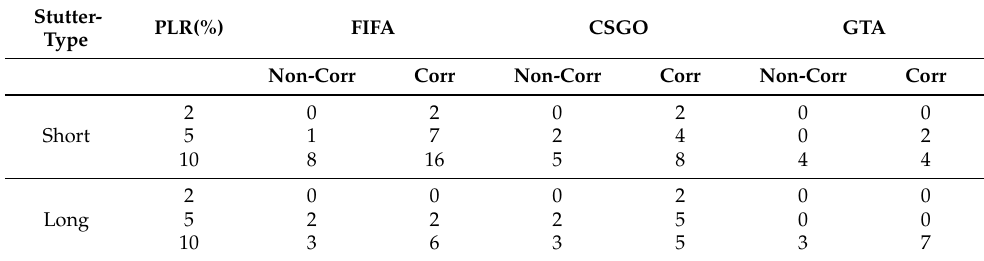
Table 3. Avg. Number of Short/Long Stutter Events for Correlated vs Non-Correlated Scenarios. Stutter-